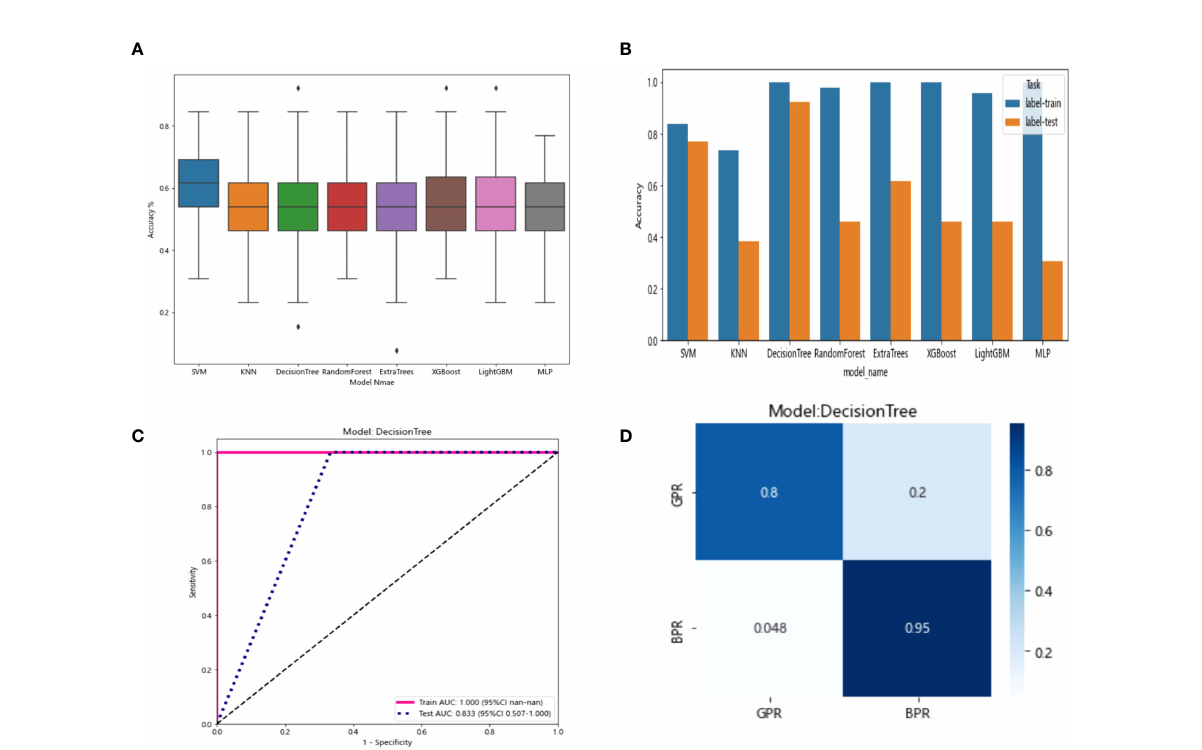
FIGURE 11 (A) Each model ’ s accuracy distribution was randomly tested 100 times by eight common machine learning algorithms. (B) Comparison of the accuracy of the best performing one out of 100 randomizations in eight machine learning algorithms. (C) AUCs of the training set and test set in the DecisionTree model. (D) Confusion matrix for the DecisionTree model.